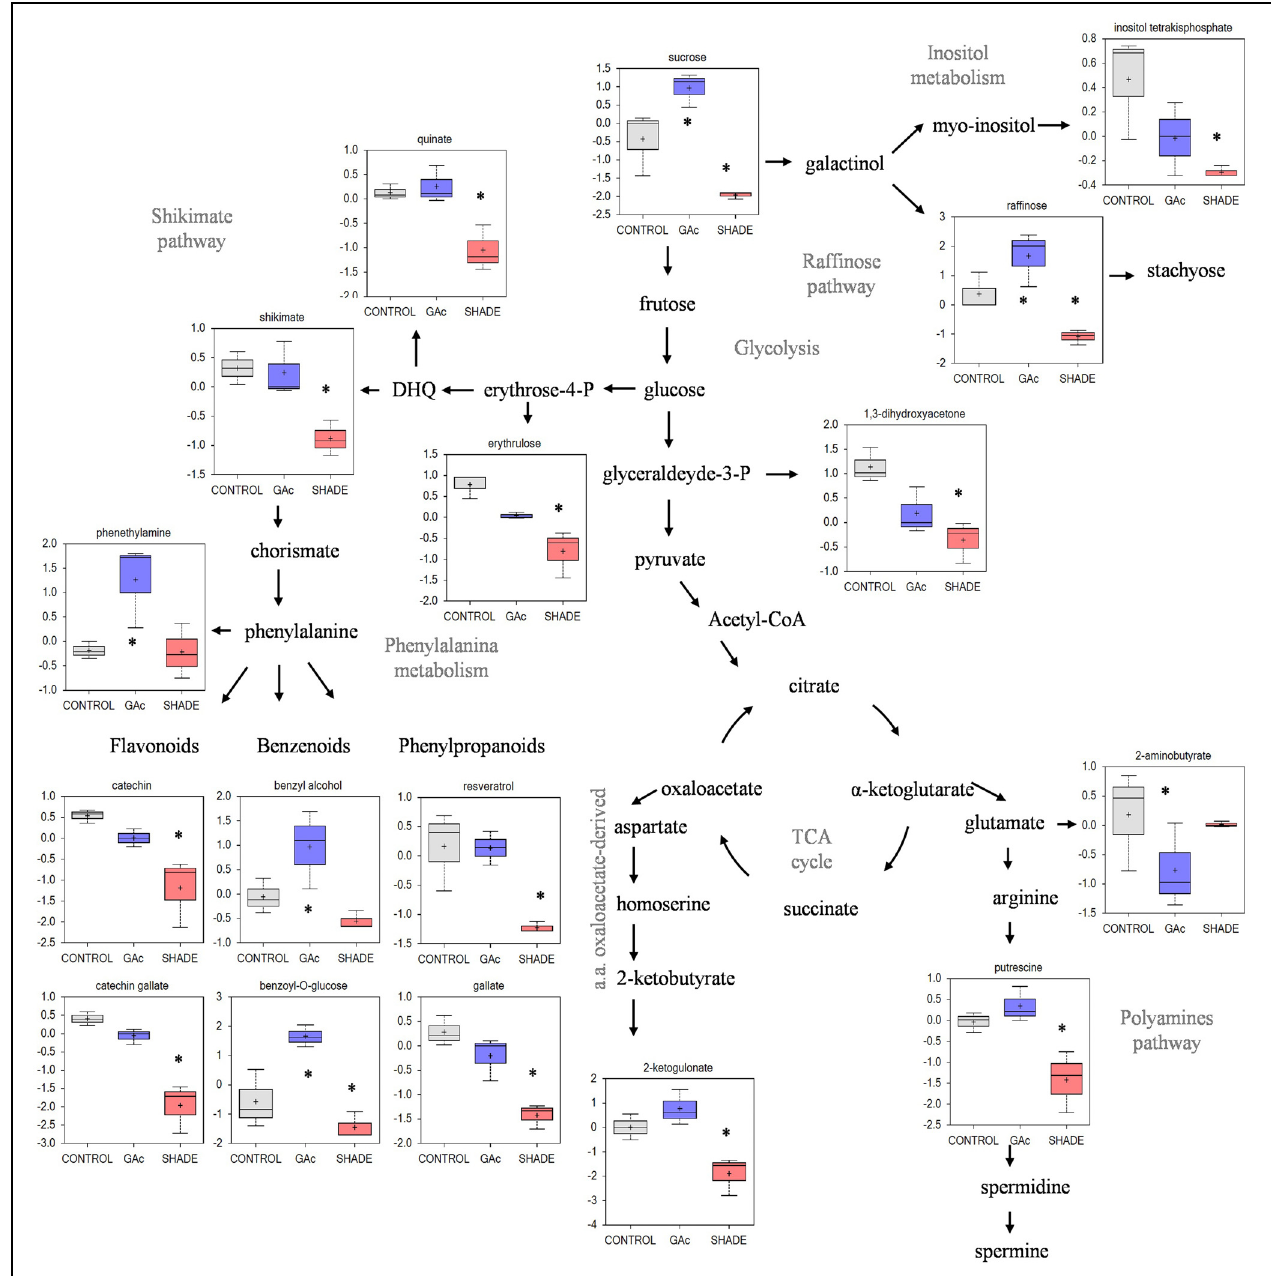
FIGURE 6 | Changes in metabolic profile in table grape inflorescences treated with GAc and Shade. Metabolites with highly significant differences are represented in the box plots and asterisks identify which treatment is